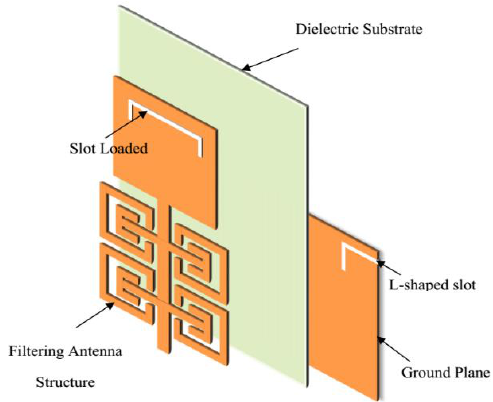
Figure 1. Filter-antenna structure layout.